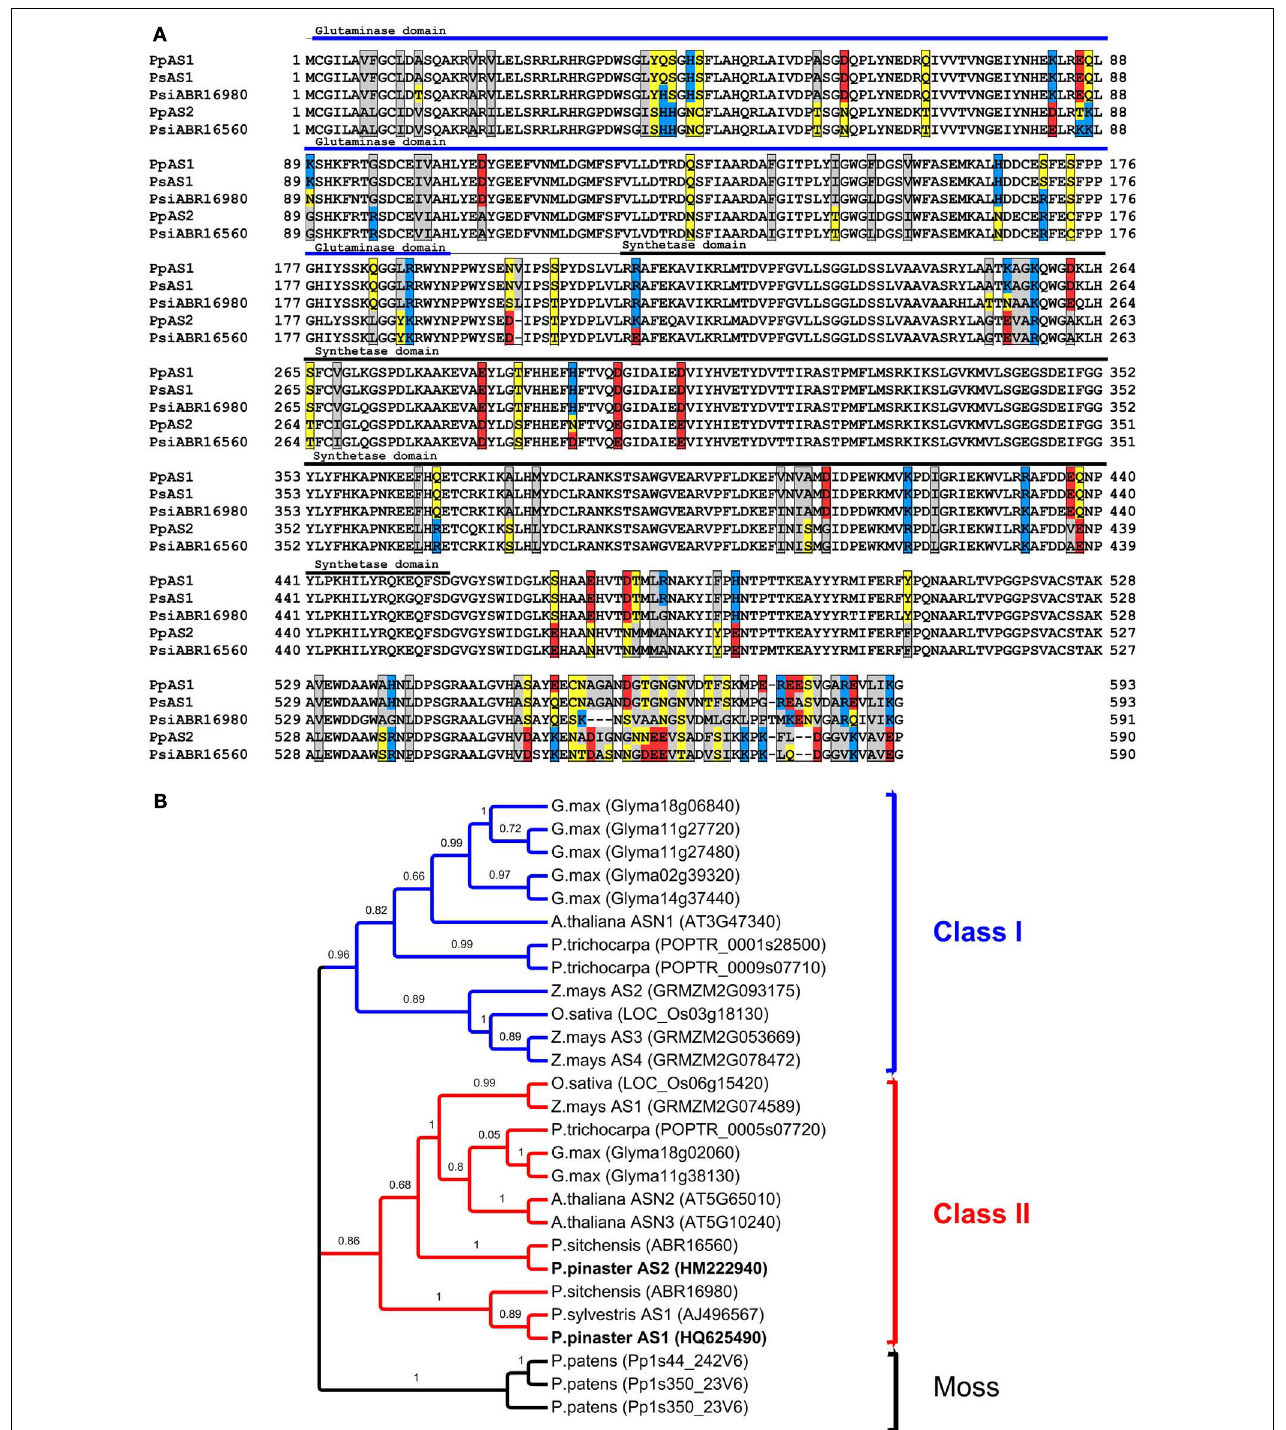
(PpAS2, HM222940), and Picea sitchensis (PsiABR16980 and PsiABR16560). (B) Unrooted phylogenetic tree of representative plant AS proteins. Amino acid sequences of conifer AS and other AS derived from the complete genome sequences of six representative plant species were aligned with TCoffee software and the phylogenetic tree was constructed with maximum-likelihood criterion. Locus name are indicated in according with phytozome nomenclature after abbreviated specie